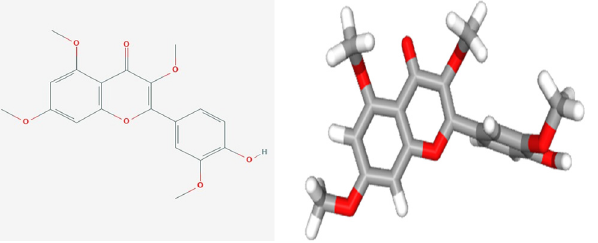
Figure 4: Shows the 2D and 3D structures of tetramethoxy hydroxy fl avone.